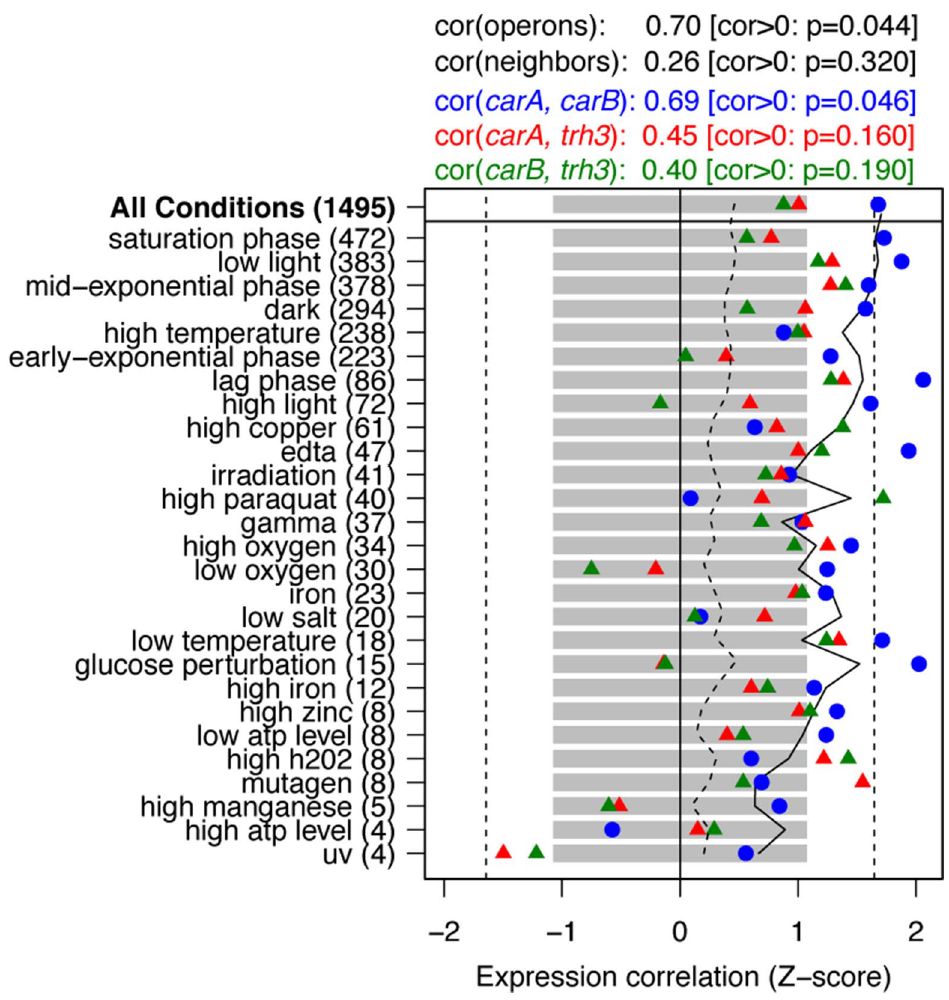
Figure 5. Gene expression correlations for carA,carB, and trh3 over a large compendium of microarray experiments. The Z-scores (horizontal axis) for pairwise gene correlations are shown for several experimental conditions (left, numbers of arrays in parentheses). Gray bars represent + / 2 1 standard deviation over all conditional gene correlations; dashed lines indicate a p -value of 0.05. A solid black line indicates the average level of correlation between co-operonic genes, which is positive ( p # 0.044). carA and carB, while non-operonic, are similarly correlated over all conditions (blue circles, p # 0.046). carA and carB are positively correlated with trh3 (red and green triangles), but weakly so ( p # 0.16 and 0.19, respectively), and not under all conditions. The mean correlation between neighboring, non-operonic genes (which includes the pairs carA vs. carB and carA vs. trh3 ) is also weakly positively correlated in general, but not significant (dashed black line; p =0.32, n =1,661 pairs of non-operonic